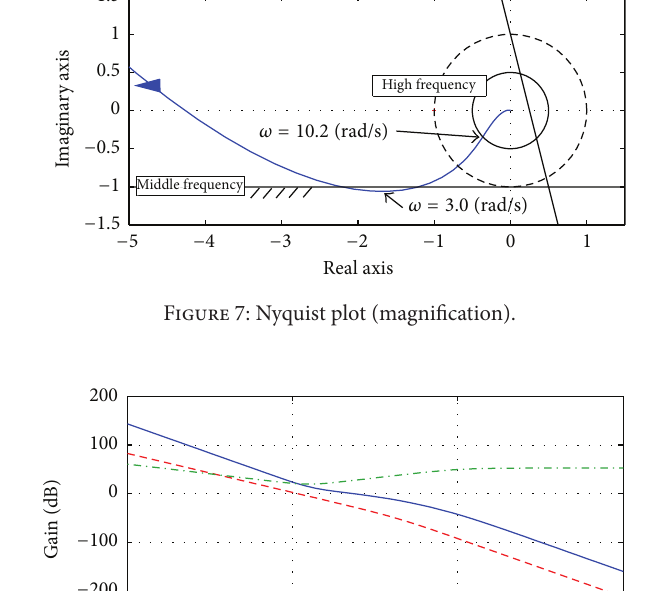
Figure 6: Nyquist plot.